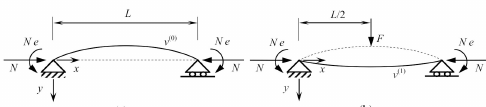
Figure 2. Reference model of the PC girder [80]: ( a ) deflection curve v (0) after the application of the eccentric prestress force N ; ( b ) deflection curve v (1) after the application of the vertical load F to the deflection curve v (0) . The dashed lines represent the initial deflection curves. Copyright © 2018, World Scientific Publishing Co. Pte Ltd. Reprinted with